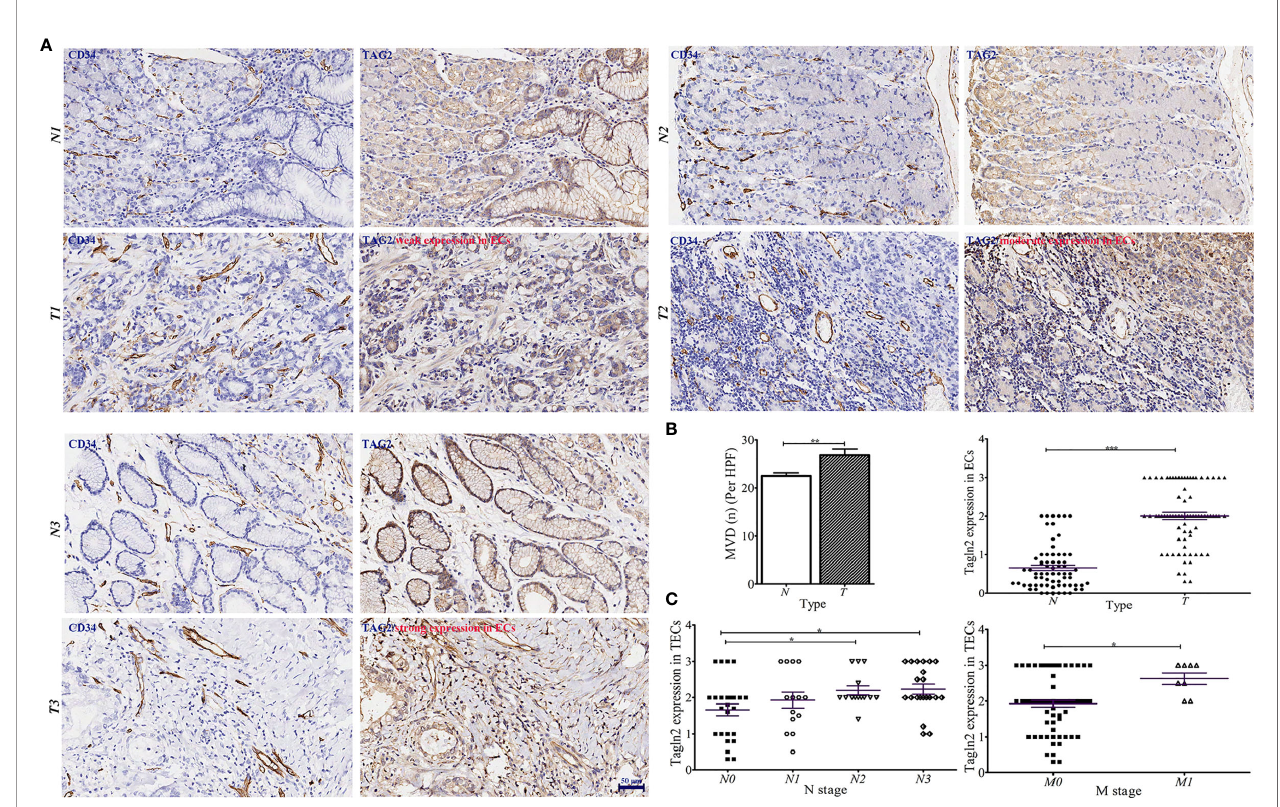
FIGURE 1 | Aberrantly increased Tagln2 protein expression in tumor-derived endothelial cells (ECs) was assessed by immunohistochemical (IHC) analysis of a gastric cancer (GC) tissue microarray (TMA) chip containing 75 tumor tissues and their paired normal counterparts. (A) IHC images from three patients with weak, moderate and strong Tagln2 expression in ECs from GC were shown, in which CD34 was used to speci fi cally label ECs. (B) The microvessel density (MVD) and IHC scores of Tagln2 expression in ECs from gastric tumor tissues (t) and paired normal counterparts (N). (C) The signi fi cantly positive relationship between the expression of Tagln2 in tumor-derived ECs from GC tissues and the presence of lymph node (N stage) as well as distant metastases (M stage) of patients. For the calculation of MVD, all stained sections were screened at 40×, and vessels were counted in three spots. MVD was expressed as the mean number of counted microvessels per high power fi eld (HPF). The expression of Tagln2 in ECs identi fi ed by CD34-positive staining was scored at 40× magni fi cation as follows: one hundred ECs were counted per slice, and the percentage of positive cells (PP) was calculated. The intensity of staining (IS) was scored as 0: negative, 1: weak, 2: moderate and 3: strong. The results were scored by multiplying the PP by the IS (immunoreactive score = PP × IS). * P < 0.05, ** P < 0.01, *** P <